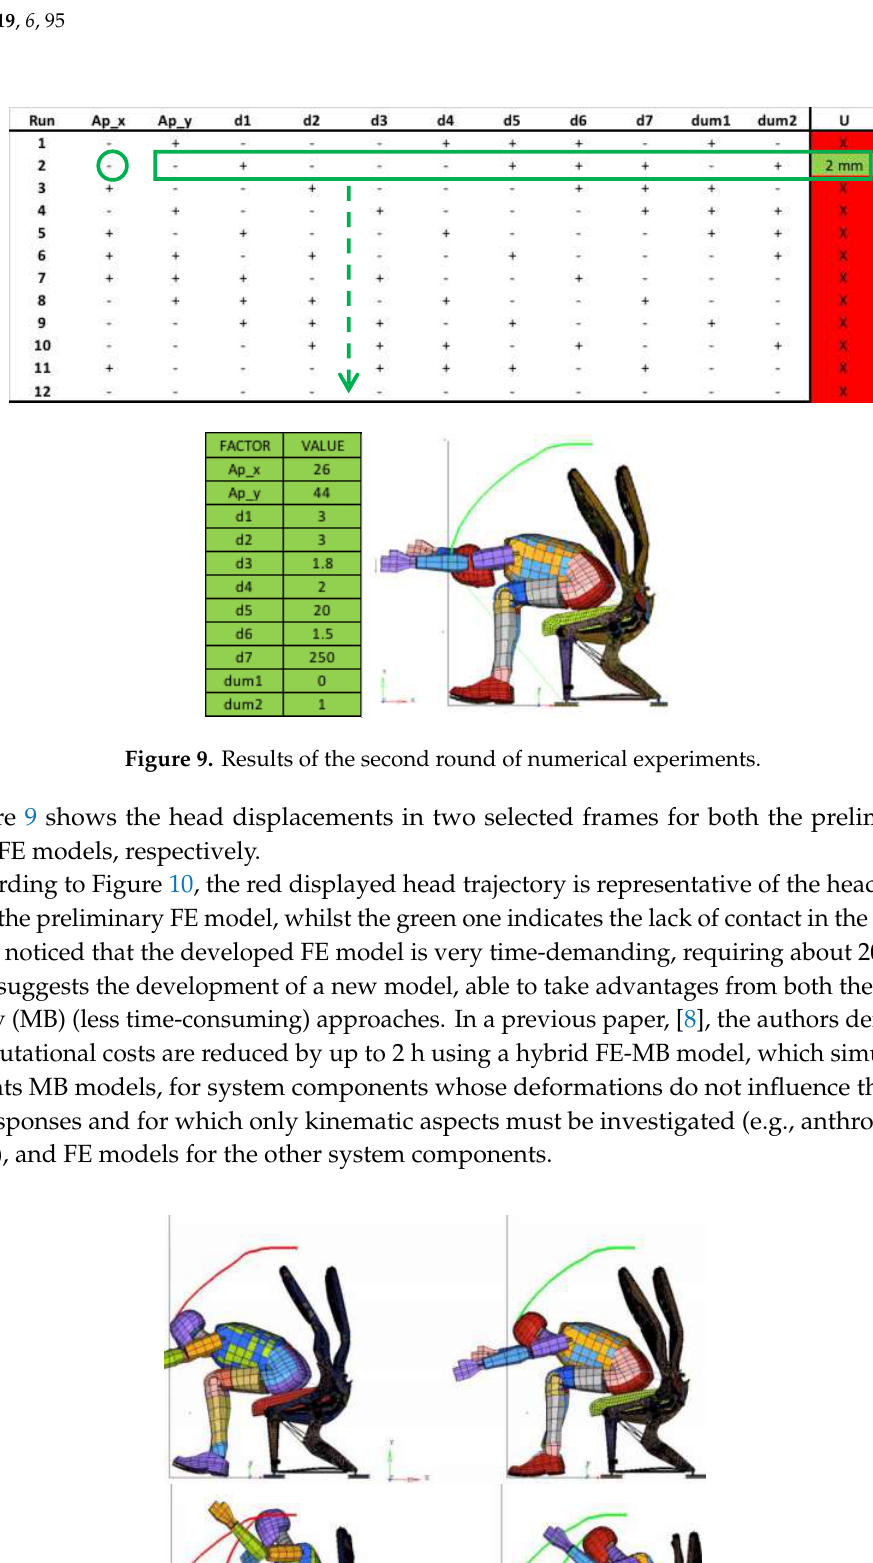
Figure 8. Design factors.